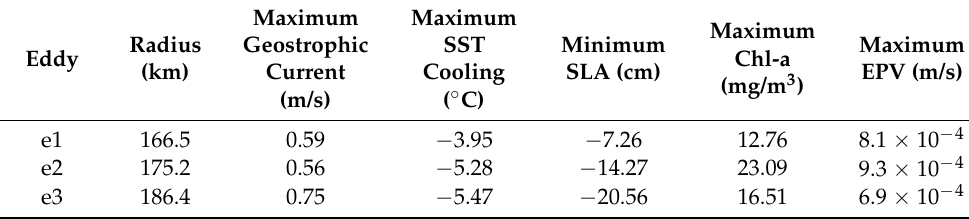
Figure 3. Spatial and temporal distributions of ( a1 – a5 ) wind speed (arrow) and EPV (shadow area), ( b1 – b5 ) SST, ( c1 – c5 ) SLA and geostrophic current (arrow), and ( d1 – d5 ) sea surface concentrations of chl-a derived from remote sensing data for 20 October–19 November 2019, overlaid with SLA contours (solid-positive and dashed-negative). e1, e2, and e3 in ( c2 – c5 ) denote the three cold eddies. The box represents the study area, and the thick black lines represent the paths of TCs Kyarr and Maha. Table 2. Statistical characteristics of the three cold